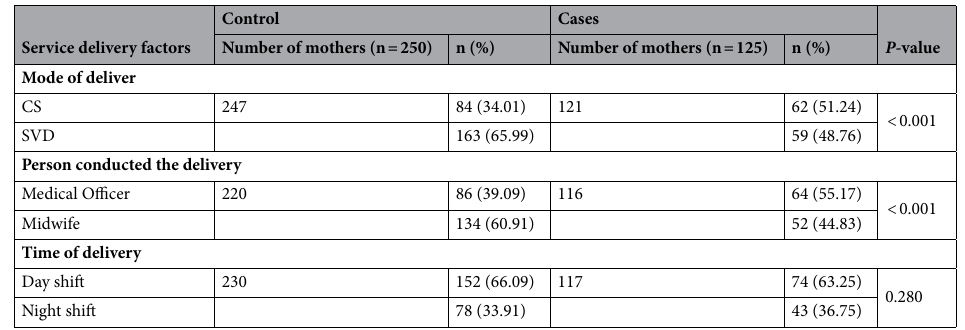
Table 3. Bivariate analysis of service delivery factors associated with intrapartum stillbirth in six public hospitals in 2016. CS Caesarian Section, SVD spontaneous vaginal delivery; (%) represent column percentage, n Total number of cases and controls that were used in the estimation of the test statistic.